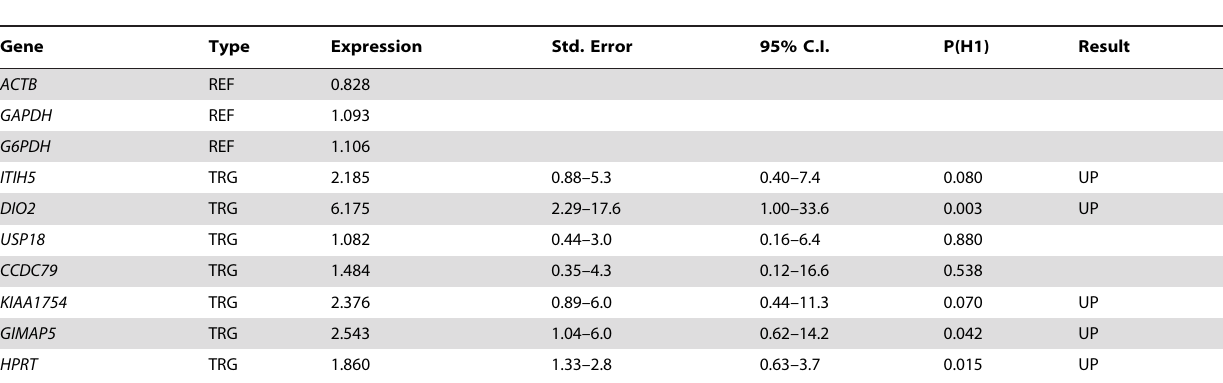
Table 4. Differential expression results of the genes studied in the liver by Real-time PCR assay from animals supplemented with 5 g of inulin kg 2 1 diet and controls using REST software ( P , 0.08